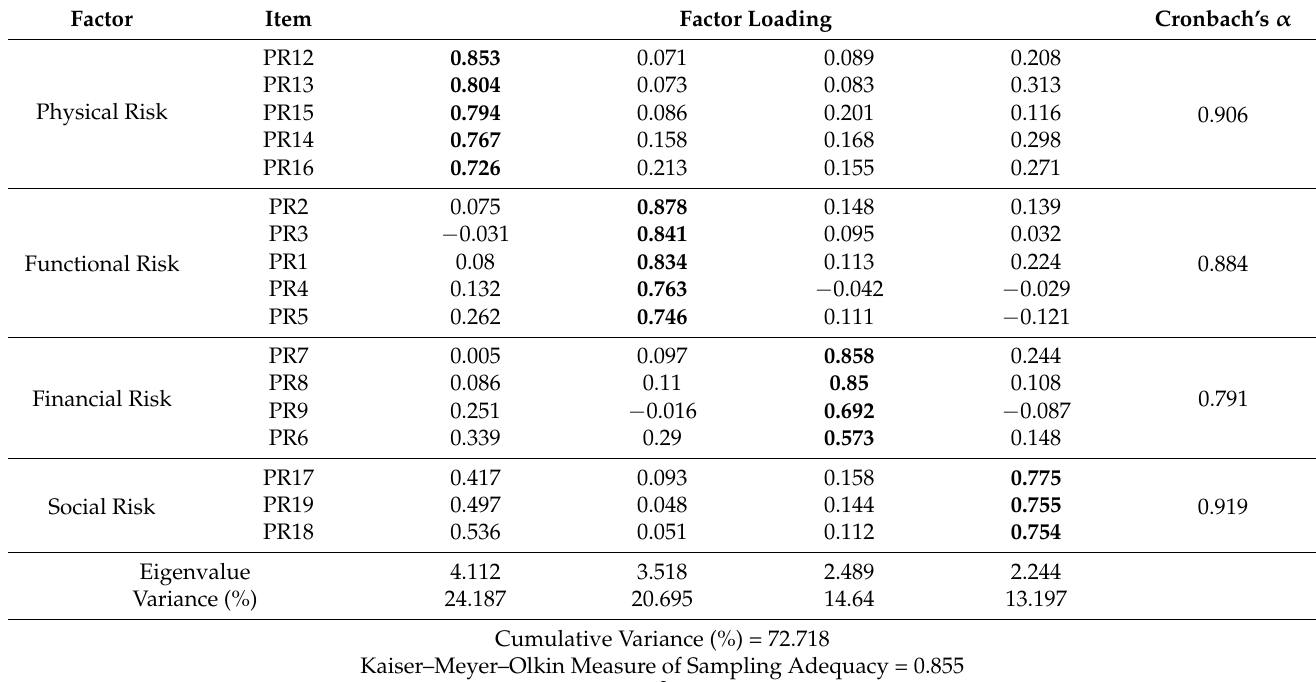
Table 4. Exploratory factor analysis and